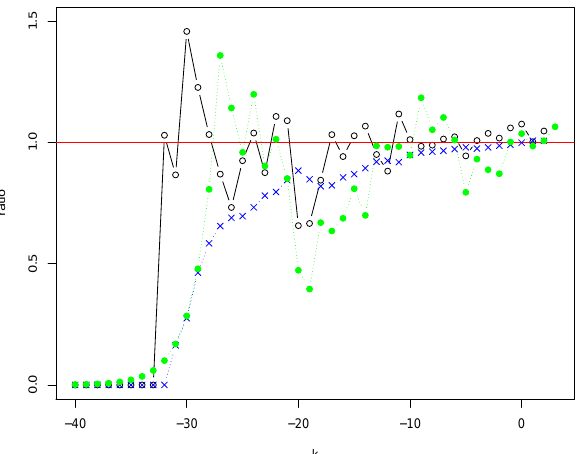
Figure 9. Ratio b φ 0 ( t k ) /φ 0 ( t k ) in terms of k , for k ∈ [ − 40 , +1] , i.e. t k ∈ [6 . 3 e-13 , 1 . 39] . Case of a Gumbel copula with parameter θ = 4 (i.e., Kendall’s τ = 0 . 75 ), n = 2000 , d = 3 . Black dots: Ratio for our estimator using Equation (25) for b φ 0 . Blue crosses : Ratio for our estimator using Equation (26) for b φ 0 . Green full dots: Ratio using estimator of φ 0 introduced by Genest et al. [25].